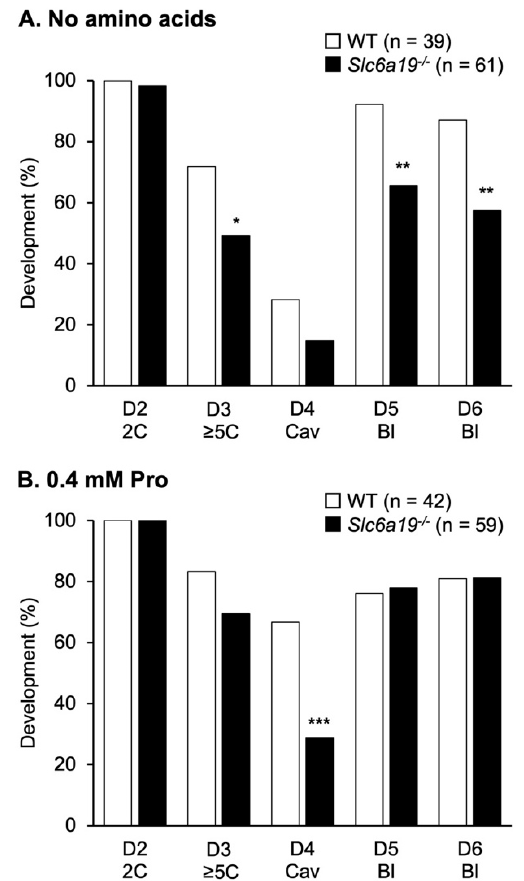
Figure 6. Pro improves development of Slc6a19 − / − embryos at ≥ 5–8-cell and blastocyst stages. Zygotes were cultured in the ( A ) absence of AAs, or ( B ) in the presence of 0.4 mM Pro and scored for development to the appropriate stage every 24 h (i.e., to the 2-cell (2C) on day 2 (D2), 5–8-cell ( ≥ 5C) on D3, cavitation (Cav) on D4, and blastocyst stage (Bl) on D5 and D6. Data on each day of development were compared by chi-square analysis of pooled data from 4–6 replicate experiments, with the total number of embryos in each group given in parentheses. Bars with an asterix are significantly different to WT at each timepoint: * p < 0.05, ** p < 0.01 and *** p < 0.001.